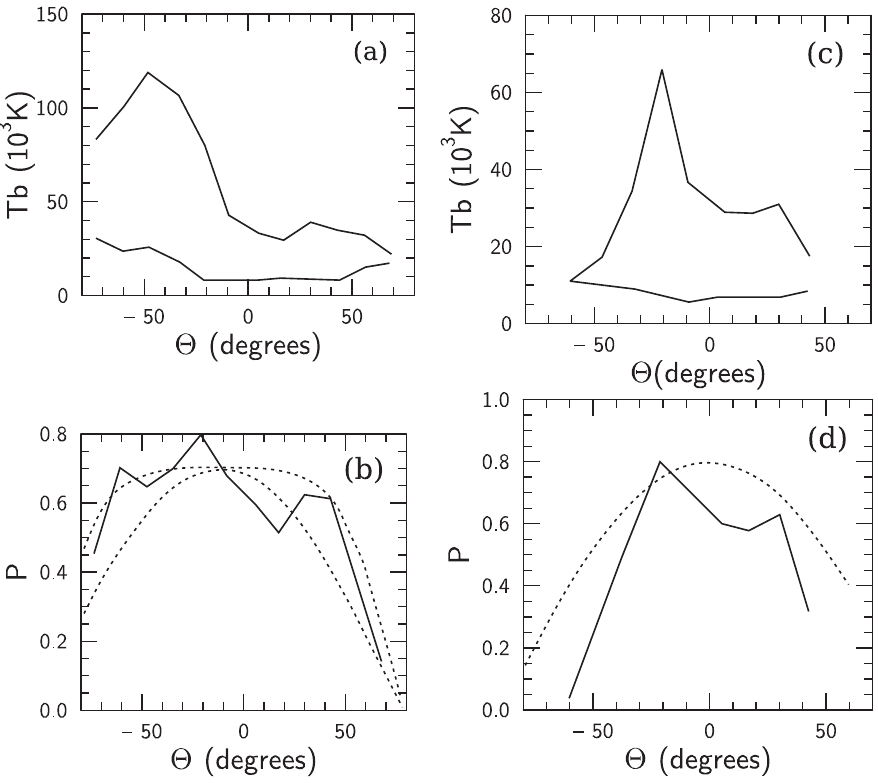
Fig. 4. AR 11312. The longitudinal dependence of (a) the 17 GHz radio brightness in both RCP ( T b o ( (cid:18) )) and LCP ( T b x ( (cid:18) )) and (b) the degree P ( (cid:18) ) of circular polarization at the point of the current maximum brightness in LCP. The longitudinal dependence of (c) the radio brightness in both RCP and LCP and (d) the degree of circular polarization at the point of the current minimum brightness in RCP. The dashed curves show the cosine and the \overextended cosine"